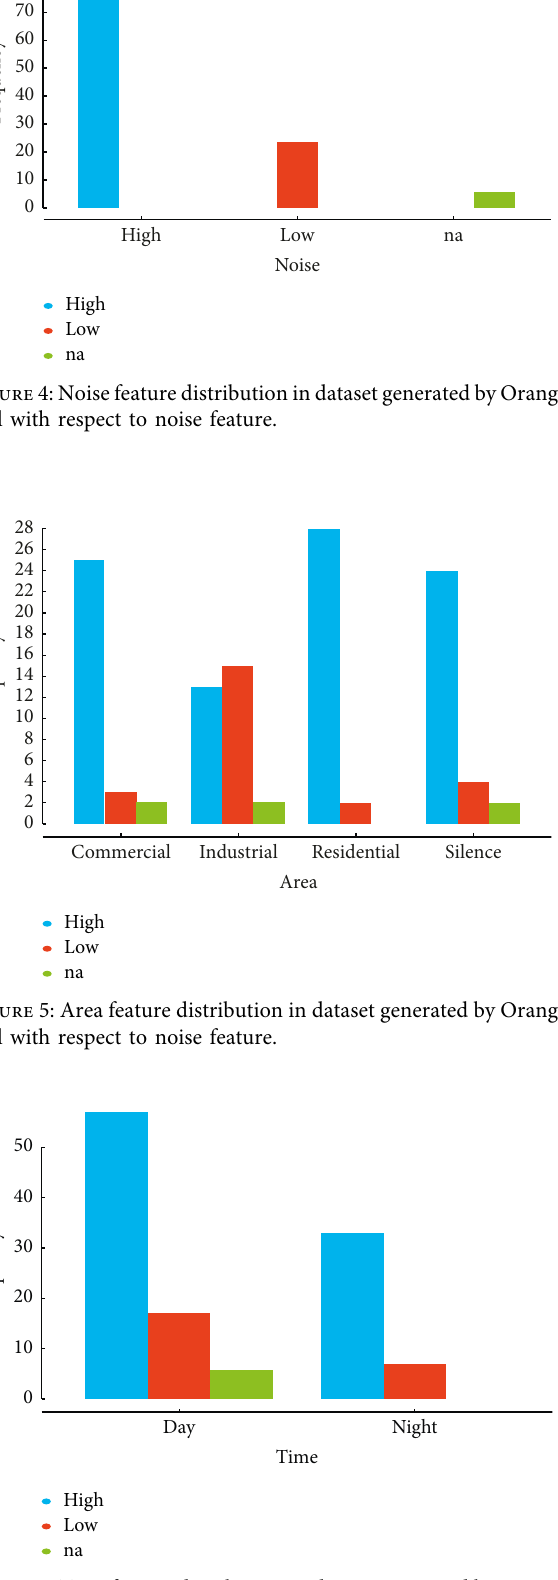
Figure 6: Time feature distribution in dataset generated by Orange tool with respect to noise